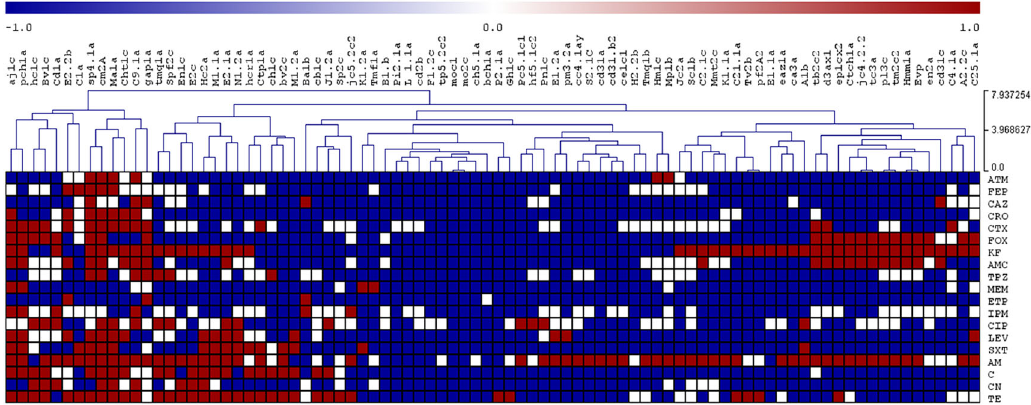
Figure 2. Profiles of antibiotic resistance and hierarchical tree of E. coli isolates. Red: resistant, White: inter- mediate, Blue: sensitive.